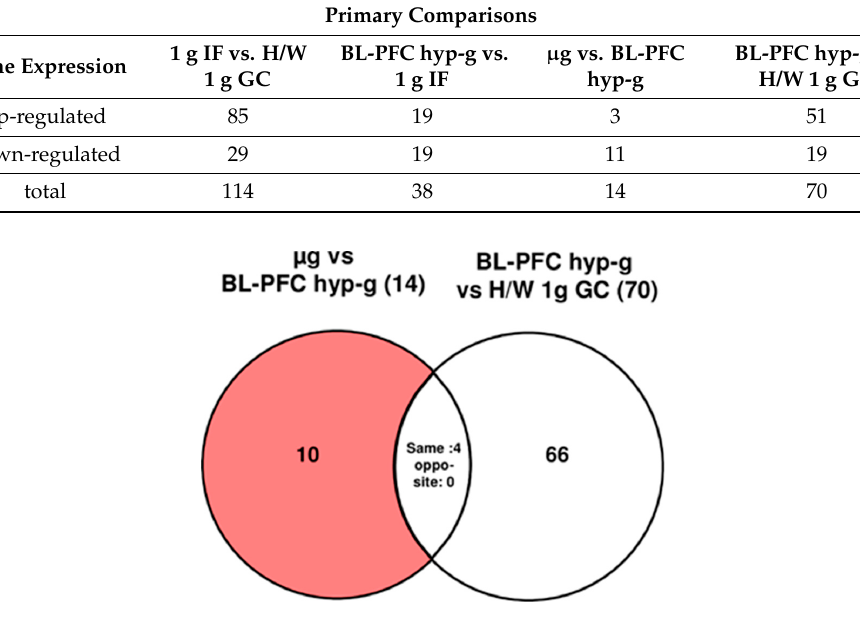
Figure 4. Strategy for the identification of microgravity- and hypergravity-sensitive probe sets in human Jurkat T cells during the 23rd DLR PFC. The different comparisons and resulting intersections for hypergravity and microgravity-sensitive probe sets are displayed as Venn-diagrams. In the circles numbers of probe sets are given that are differentially expressed with a p -value < 0.05. The red area shows the number of BL-controlled (BL-PFC hyp-g versus H/W 1 g GC) microgravity-sensitive transcripts: differentially expressed in the comparison µg versus BL-PFC hyp-g excluding those differentially expressed in the control comparison BL-PFC hyp-g versus H/W 1 g GC that are regulated in the same direction. For the abbreviations of the experiment group names see Table 1. Table 3. Definition and numbers of hypergravity- and microgravity-sensitive probe sets that are differentially expressed in response to hypergravity or microgravity in Jurkat T cells during parabolic flight.